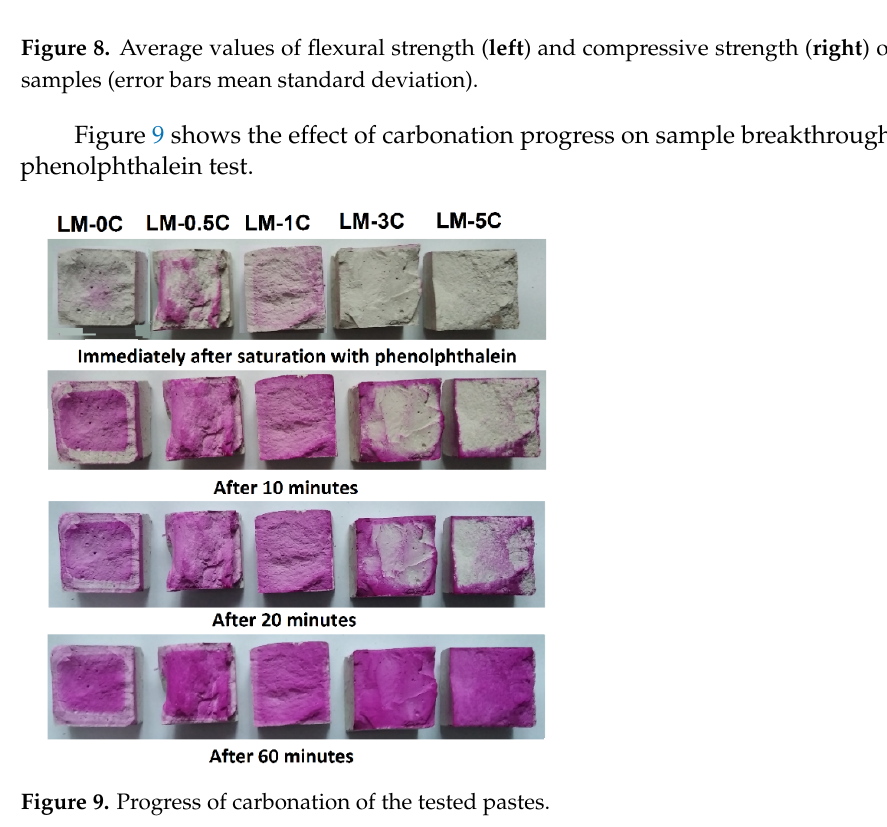
Figure 8. Average values of flexural strength ( left ) and compressive strength ( right ) of the tested samples (error bars mean standard deviation).